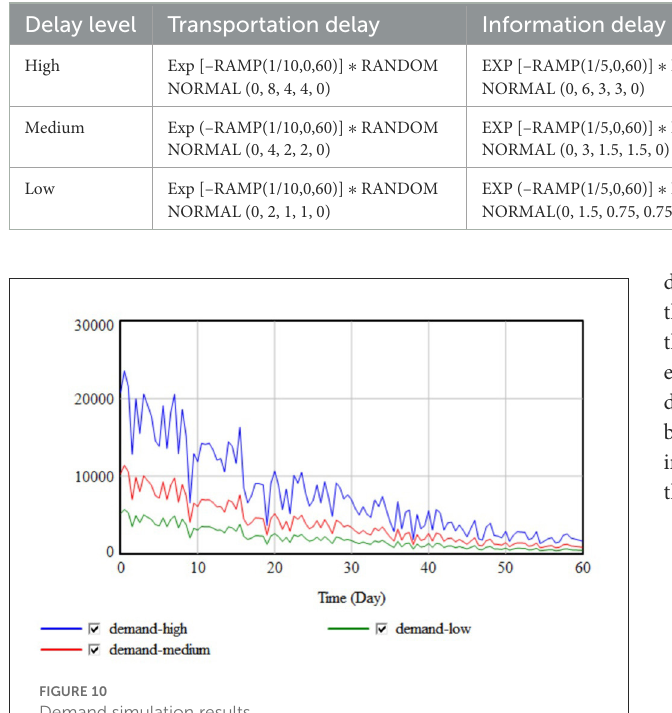
FIGURE10 Demand simulation results.